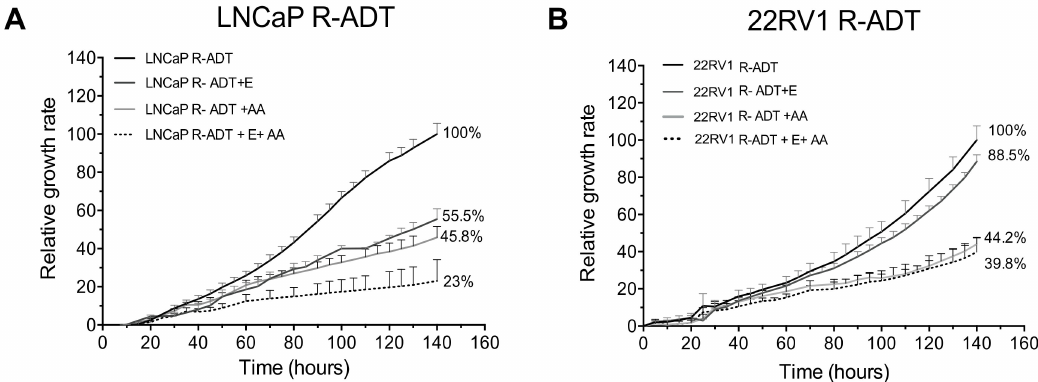
Figure 4. R-ADT cells treated with a NHA as second-line treatment. ( A ) LNCaP R-ADT cells were treated with 40 µ M Enz (R-ADT + E); 20 µ M AA (R-ADT + AA) and 40 µ M Enz + 20 µ M AA (R-ADT E + AA) for 5 days. Results have been standardized considering the final value after 5 days of control cultures to 100%. Data shown correspond to the mean ± SD calculated from the quadruplicates made for each condition. ( B ) Results obtained for the 22RV1 R-ADT cell line under the same experimental conditions than LNCaP R-ADT from section